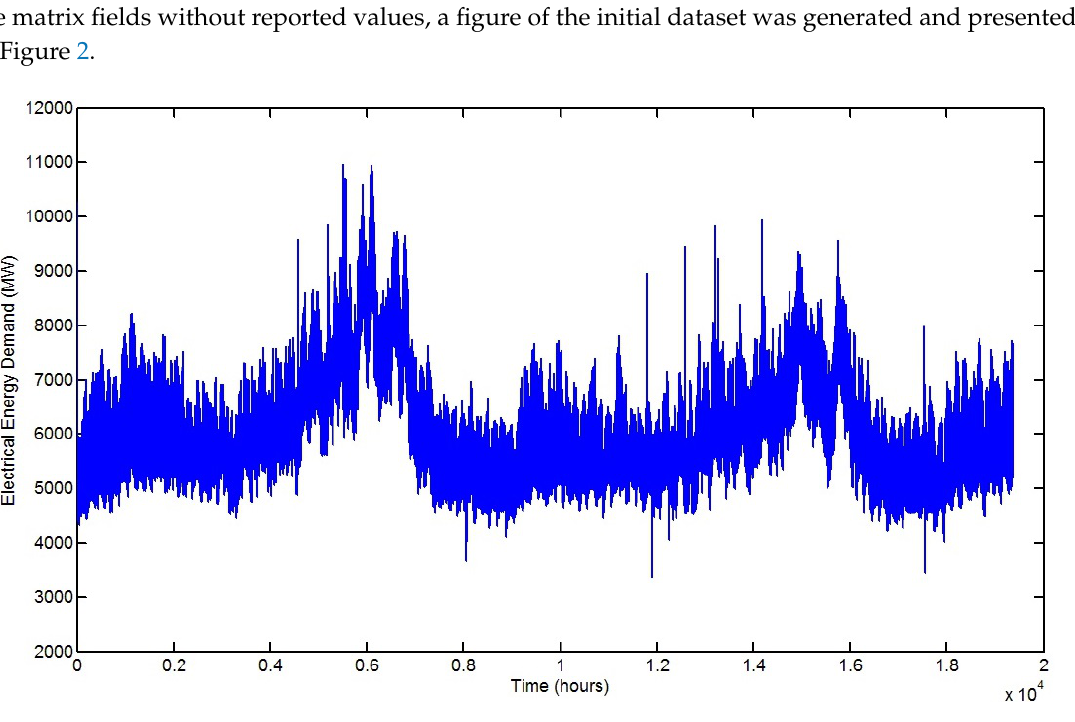
Figure 2. Electrical power demand data for Bonneville, Oregon, USA, from 2 July 2015